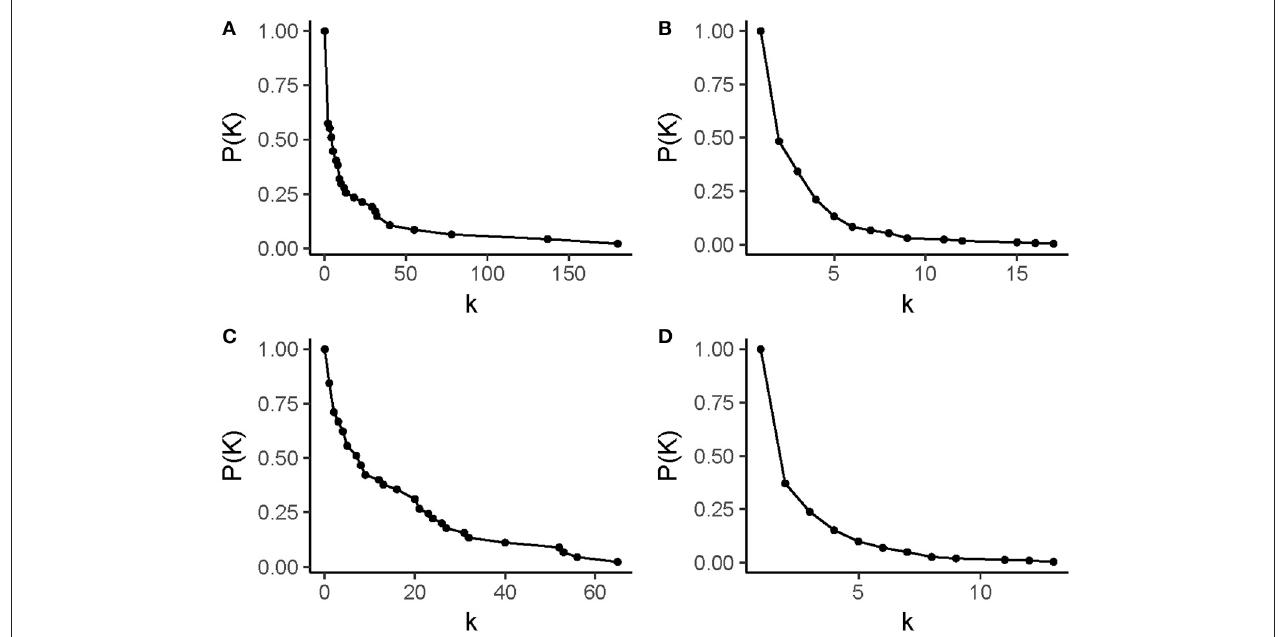
FIGURE 4 | Degree distributions in drug-pathway networks. (A) drug nodes in the CMap-based network, (B) pathway nodes in the CMap-based network, (C) drug nodes in the LINCS-based network, and (D) pathway nodes in the LINCS-based network. In each panel, the x-axis represents a degree value ( k ) and the y-axis represents the complementary cumulative frequency for a value of k , P ( K ). Drug nodes have degree values that range from 0 to 180 in the CMap-based network and 0 to 65 in the LINCS-based network. Pathways have degree values that range from 1 to 17 in the CMap-based network and 1–13 in the LINCS-based network. It should be noted that in all degree distributions, nodes with higher degree values are fewer than nodes with low degree